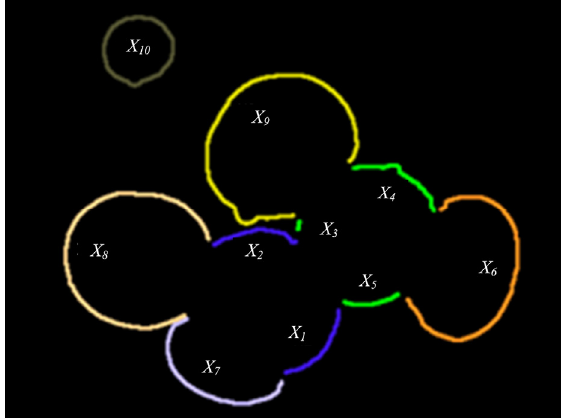
Figure 12. Grouped outline fragments.